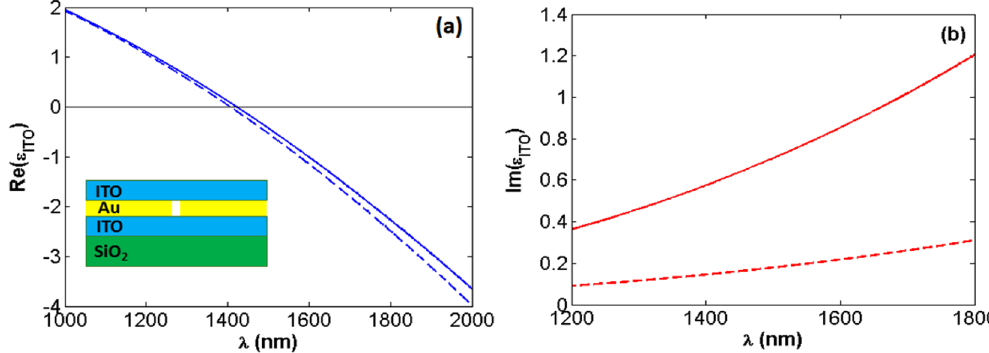
Figure 5. Solid curves in panels (a) and (b), respectively, illustrate the real and imaginary parts of epsilon of a realistic ITO with γ p = 0.51 × 10 14 rad / s 30 . For the low-loss ITO case, for which γ p = 2.05 × 10 14 rad / s , the data are represented in dashed